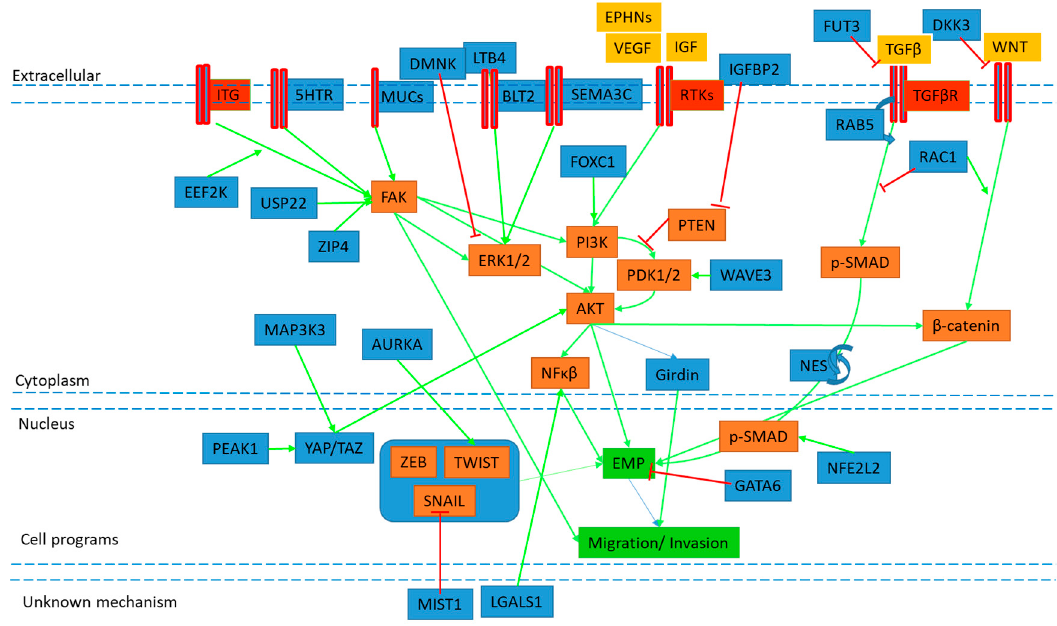
Figure 2. Simplified overview of the proposed mechanisms of novel candidates.